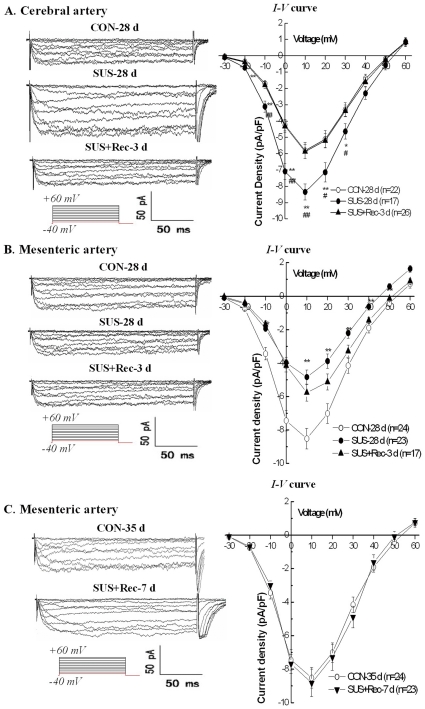
Comparison of whole-cell CaL current densities in cerebral (A) and small mesenteric VSMCs (B and C) isolated from CON, SUS, and SUS+Rec rats.CON: simultaneous control rats, SUS: 28-day tail-suspended rats, SUS+Rec: tail-suspended rats submitted to a recovery period of 3 or 7 days at the end of 28-day suspension. Representative recordings in the left panel were used to show the whole-cell CaL currents in different groups. The mean I–V curves were further expressed in terms of current densities in the right panel. Values are means ± SE with the number of cells recorded in parentheses. *P<0.05 and **P<0.01 as compared with control by ANOVA.